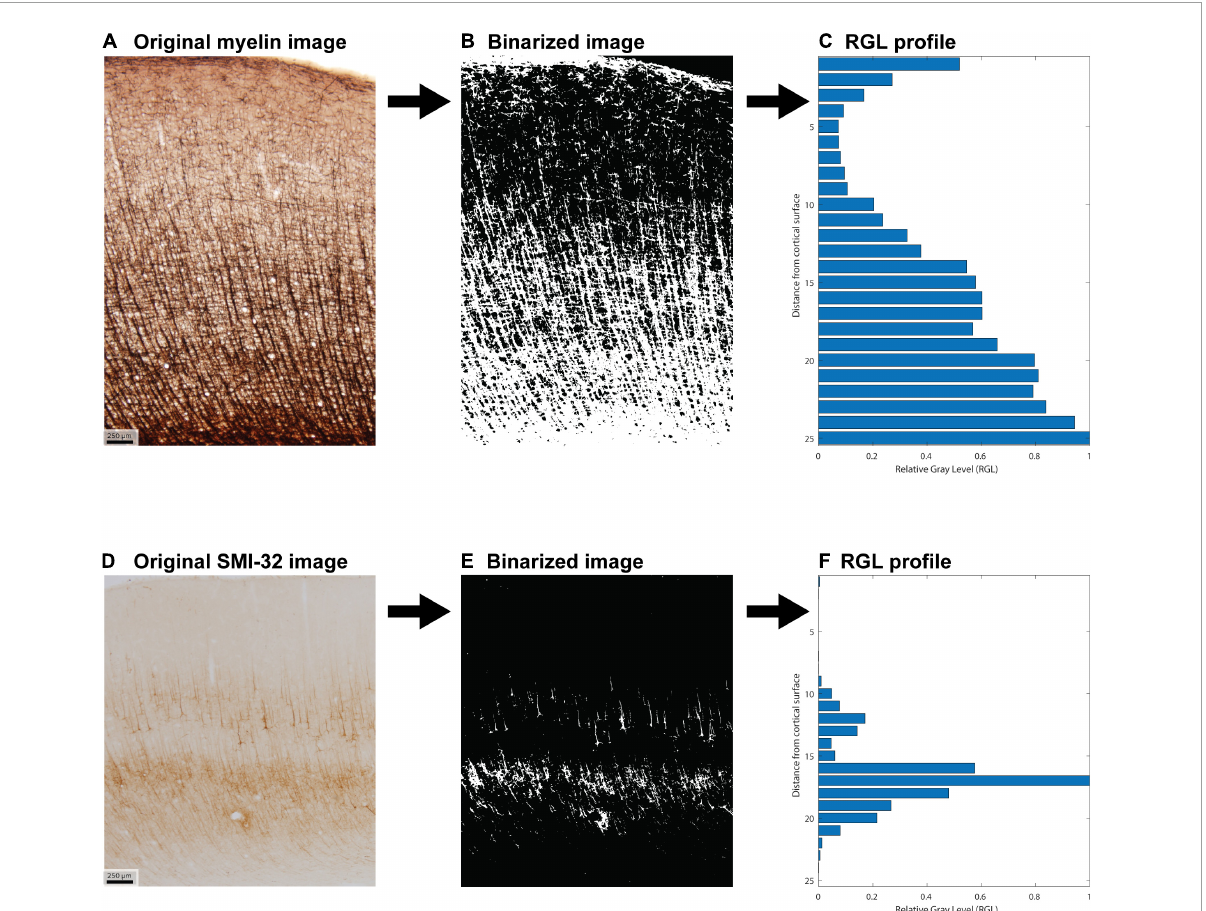
FIGURE2 Example of image processing used to create the feature vector for each cortical area. (A) Original photomicrograph of myelin stain of area 46 dorsal. (B) Corresponding binarized image. (C) Relative gray level (RGL) profile generated from the binarized image. (D–F) Analogous steps for a photomicrograph of SMI-32 stain of area 46